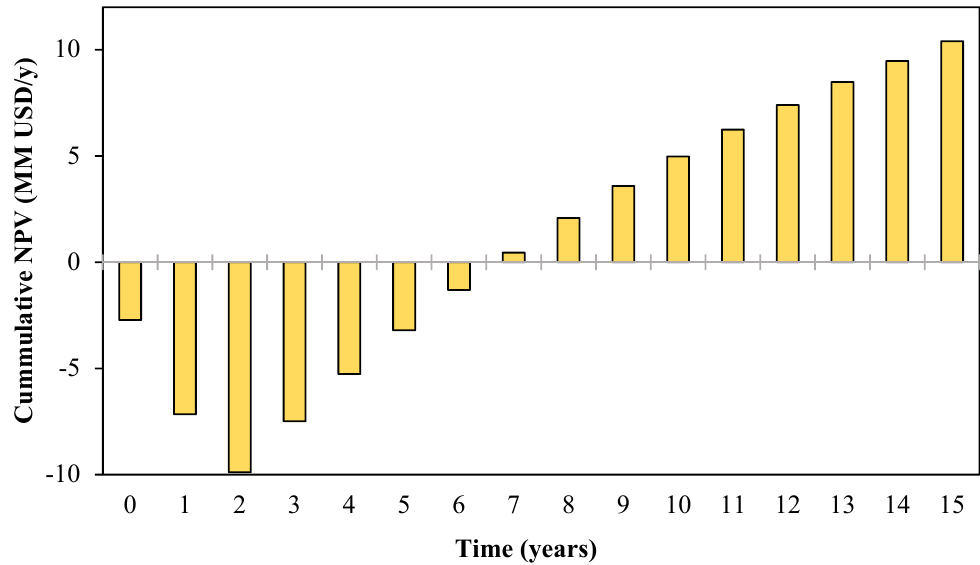
Figure 8. The net present value for the mass integrated approach for shrimp biorefinery.